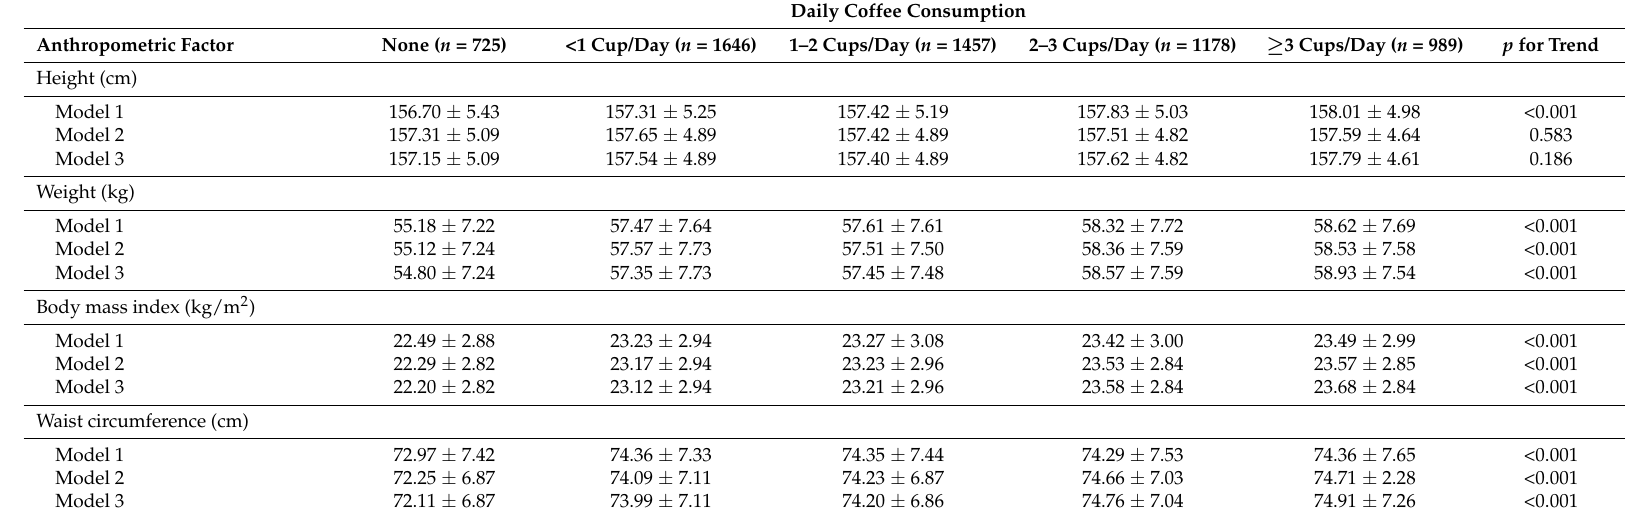
Table 2. Anthropometric measurements of the study participants stratified by coffee consumption